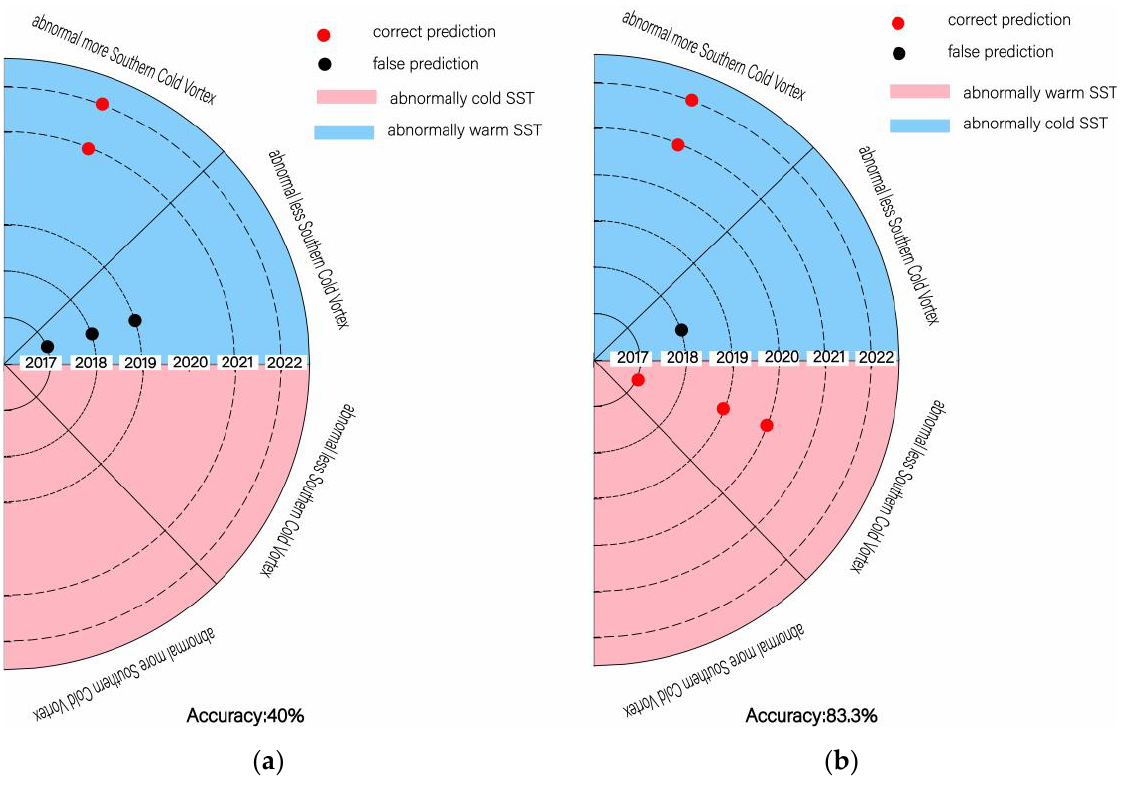
Figure 7. Forecast accuracy of southern NCV using the ( a ) North Atlantic SST tripole (NAT) and ( b ) tropical Atlantic SST.